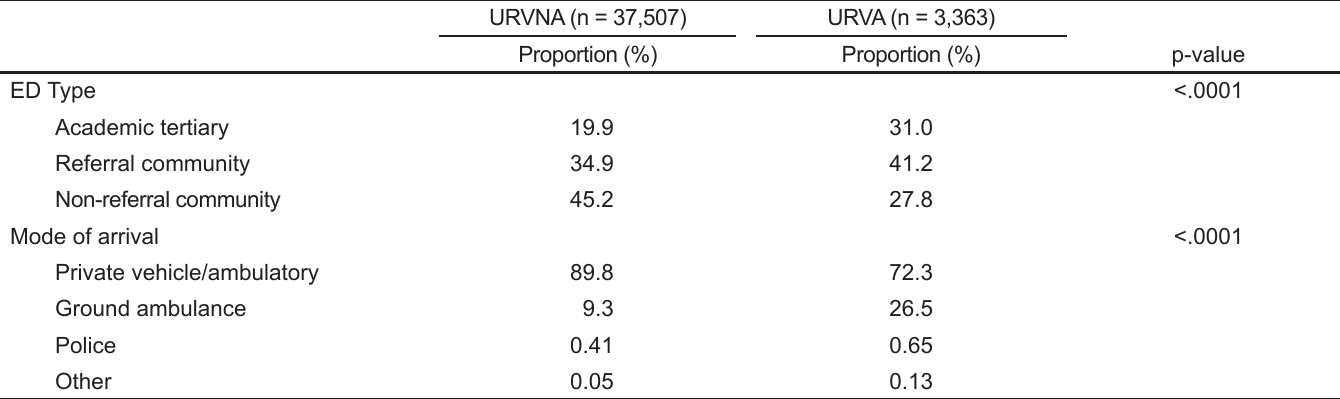
Table 2. Frequency distributions for URVNA and URVA populations.